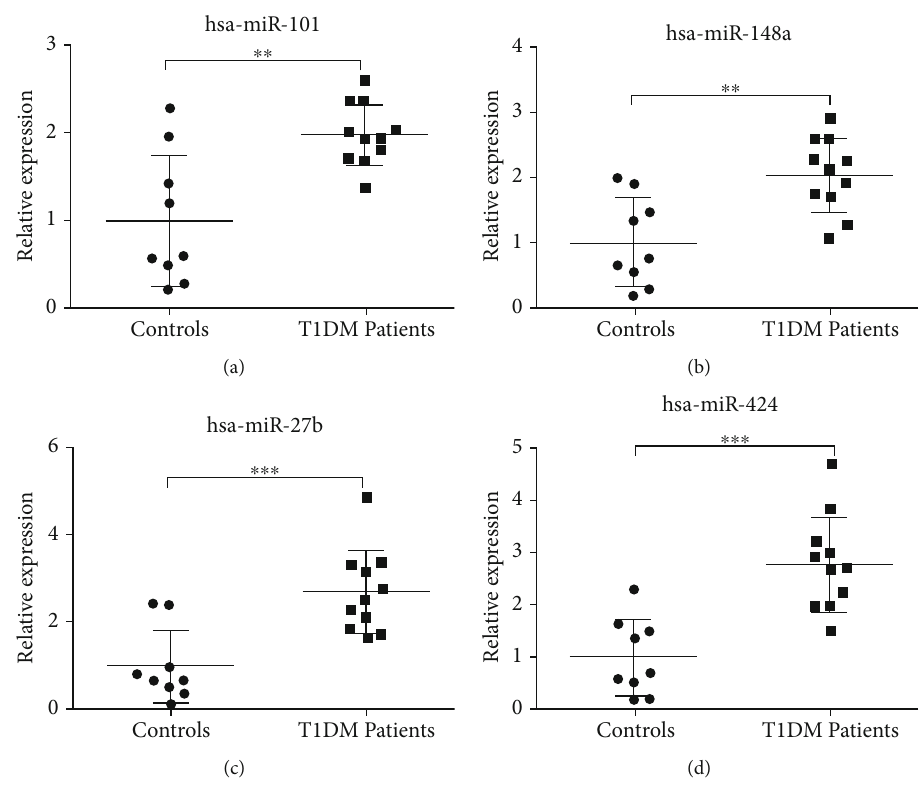
Figure 4: Relative expression of microRNAs evaluated by qRT-PCR, whose predicted targets are associated with oxidative stress response and DNA repair processes in PBMCs of T1D patients compared to the control group. The assay was performed for 11 samples of T1D patients and nine controls, which were the same used for the microarray method. Expression values of (a) hsa-miR-101 , (b) hsa-miR- 148a , (c) hsa-miR-27b , and (d) hsa-miR-424 were normalized by the endogenous RNU48 gene. The bars represent the mean ± standard deviation . ∗∗ indicates statistically signi fi cant values for p < 0 : 01 ; ∗∗∗ p < 0 : 001